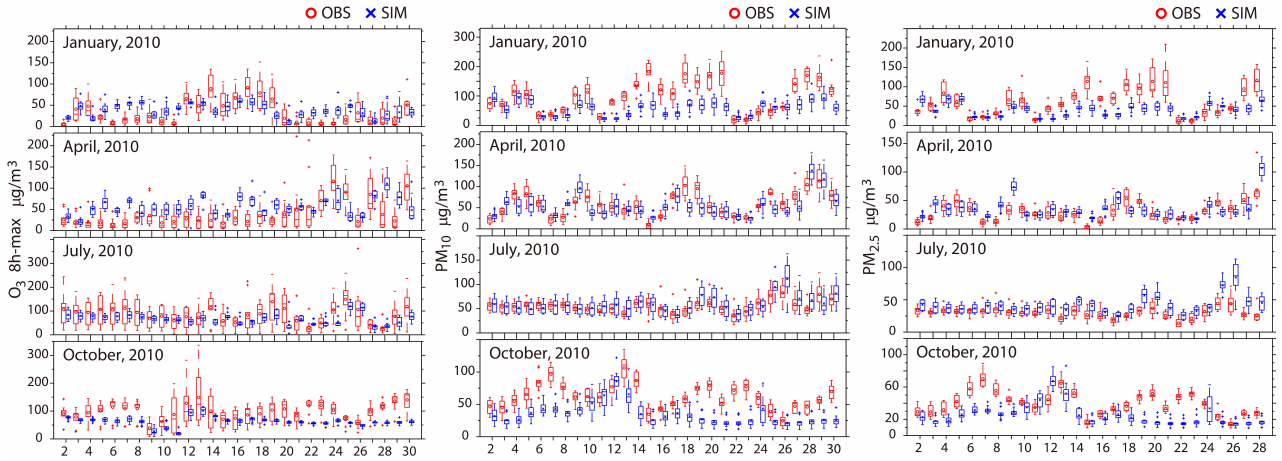
Fig. 10. Comparison between observed and simulated concentrations of air pollutants (daily maximum 8h concentration of O 3 , PM 10 and PM 2 . 5 ) in January, April, July and October 2010. On each box, the central mark is the median, the edges of the box are the 25th (q1) and 75th (q3) percentiles, the whiskers extend to the most extreme data points not considered outliers, and points are drawn as outliers (symbol “ + ”) if they are larger than q 3 + 1.5 ( q 3 – q 1 ) or smaller than q 1 –1.5 ( q 3 – q 1 ) . The open cycles and Xs are the observed and simulated averages,